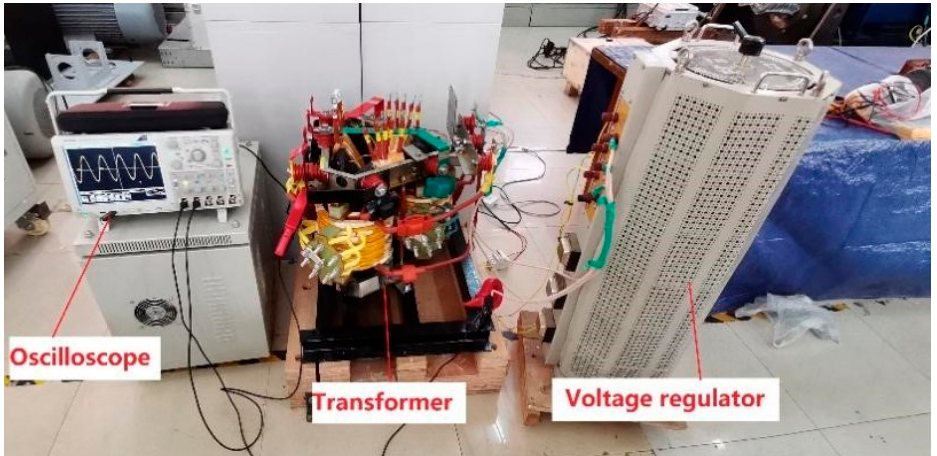
Figure 12. This is a figure. Schemes follow the same formatting. Figure 12. Schemes follow the same